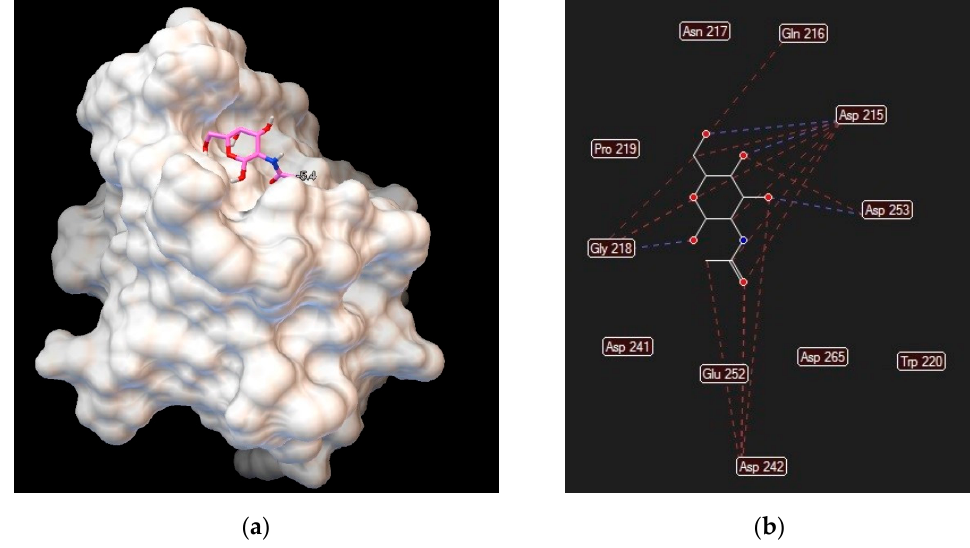
Figure 3. Asialoglycoprotein receptor (Protein Data Bank entry 1DV8, gene symbol ASGR1) binding interactions with N – acetylgalactosamine: ( a ) ligand conformation inside the binding site; ( b ) specific interactions are hydrogen bonds (blue dashed lines) and steric interactions (red dashed lines).